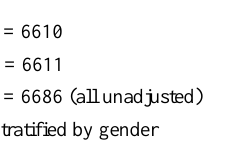
Table 3 describes unadjusted potential predictors of nonusage attrition for 52 week subscribers using univariate analyses. In the multiple regression analysis (Table 3), eating